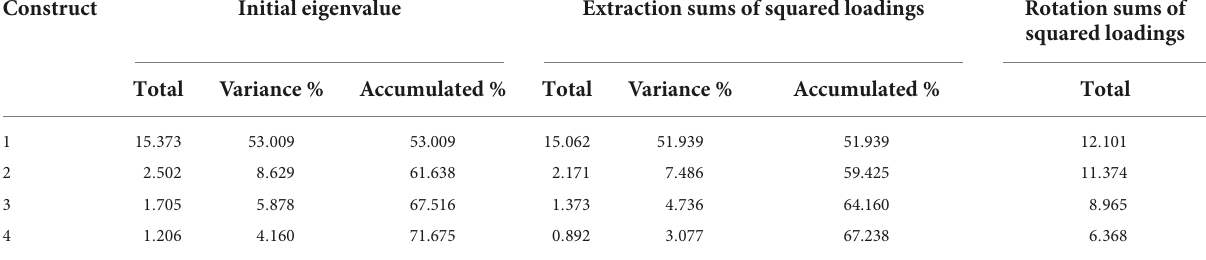
TABLE 3 Total explained variance of the fourth exploratory factor analysis